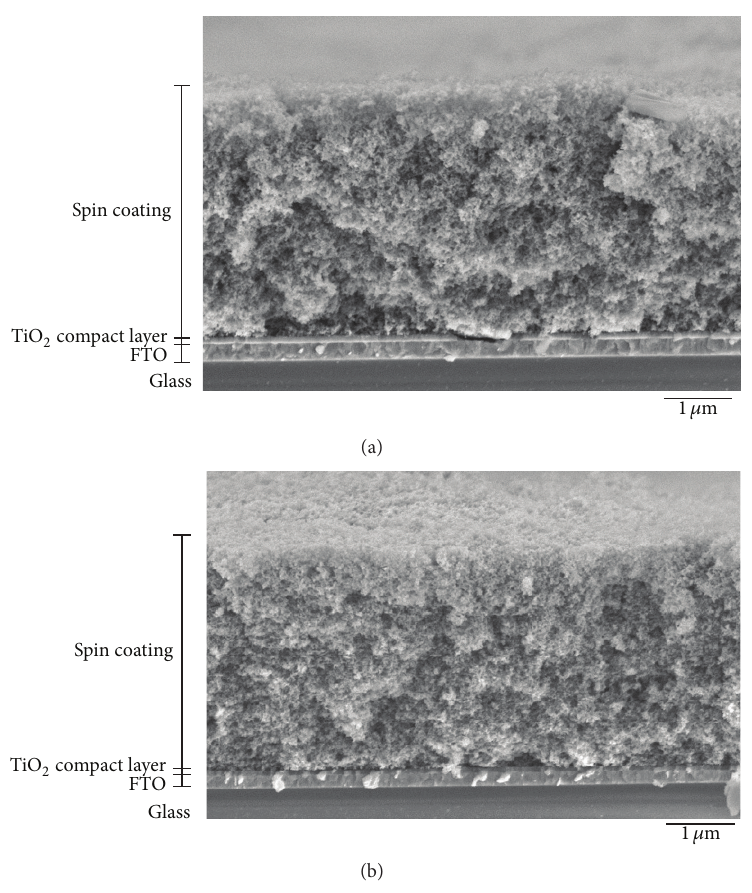
Figure 9: The SEM cross-sectional image (a) corresponding to Figure 8(b) and (b) corresponding to Figure 8(c).